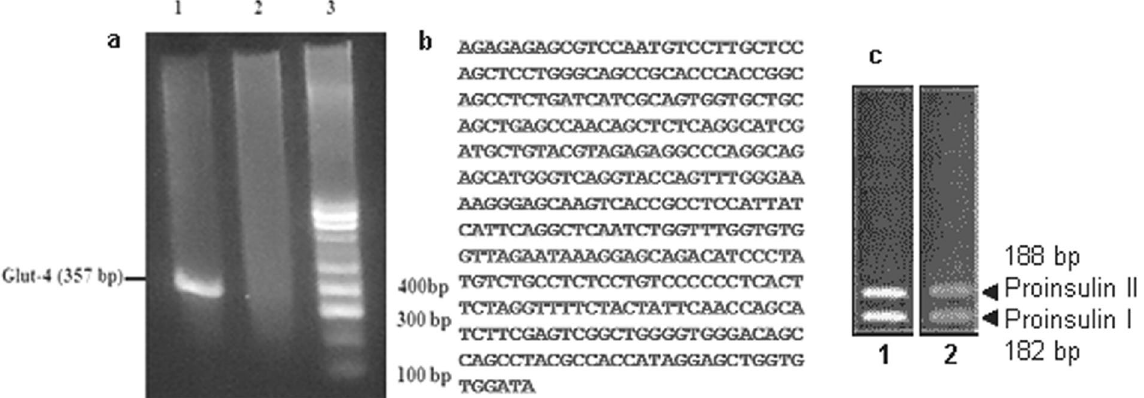
Figure 7. Role of dermcidin in Glut-4 and insulin gene expression. The liver cell homogenate was incubated with 0.02 M glucose in the presence and absence of 0.2 µ M DCN-2 for 30 min at 37 °C. cDNA was prepared from the liver cells by RT-PCR method. Panel-a: Agarose gel electrophoresis for Glut -4 gene expression. Lane-1 represents the Glut-4 gene (357 bp) in the liver hepatocytes in presence of glucose; Lane-2 represents the no expression of Glut-4 gene in the liver hepatocytes in presence of both glucose and DCN-2 and Lane-3 represents the standard base-pair marker. Panel-b: The sequence of cDNA from the liver hepatocytes of mice incubated with glucose representing Glut-4 gene. The sequence was matched with the known DNA sequence of mice Glut-4 gene and the alignment score was > 85%. Panel-c: Agarose gel electrophoresis of pro-insulin genes (cDNAs) in liver cells. Lane-1 represents the expression of pro-insulin genes I and II in the presence of 0.02 M glucose. Lane-2 represents the reduced expression of pro-insulin genes in the presence of both glucose and DCN-2. Results shown are representatives of the optical densities obtained from 6 different experiments using 6 different